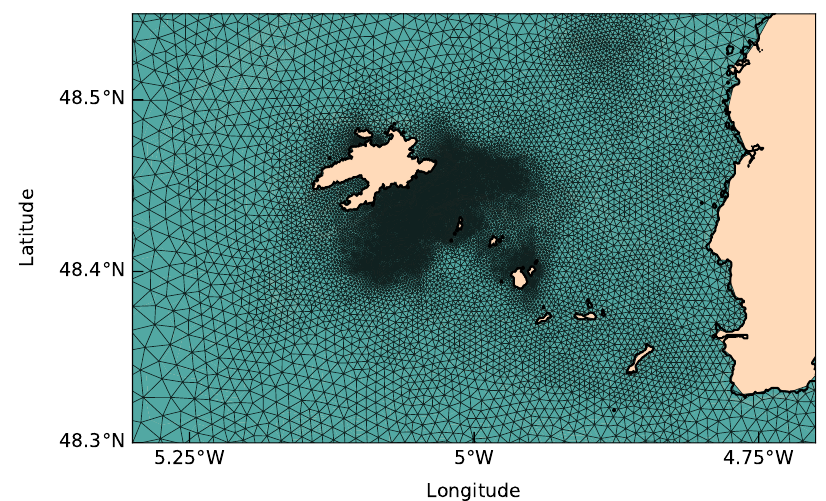
Figure 2. Detailed view of the unstructured computational grid of TELEMAC around Ouessant-Molène